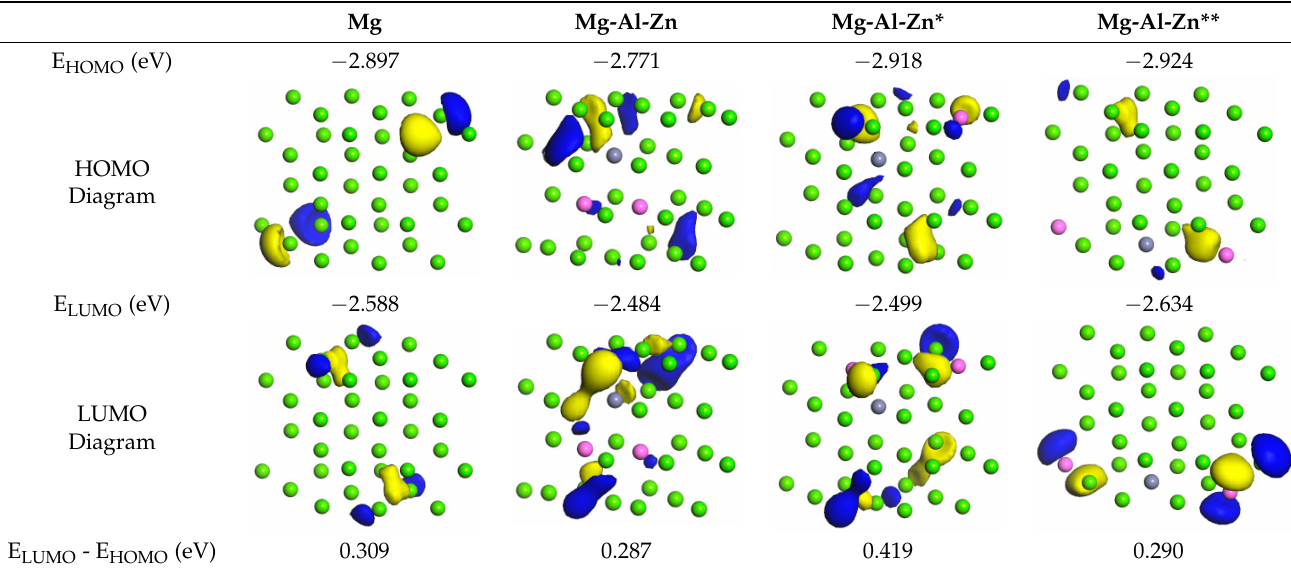
Table 1. Results of HOMO and LUMO energy with different Mg and